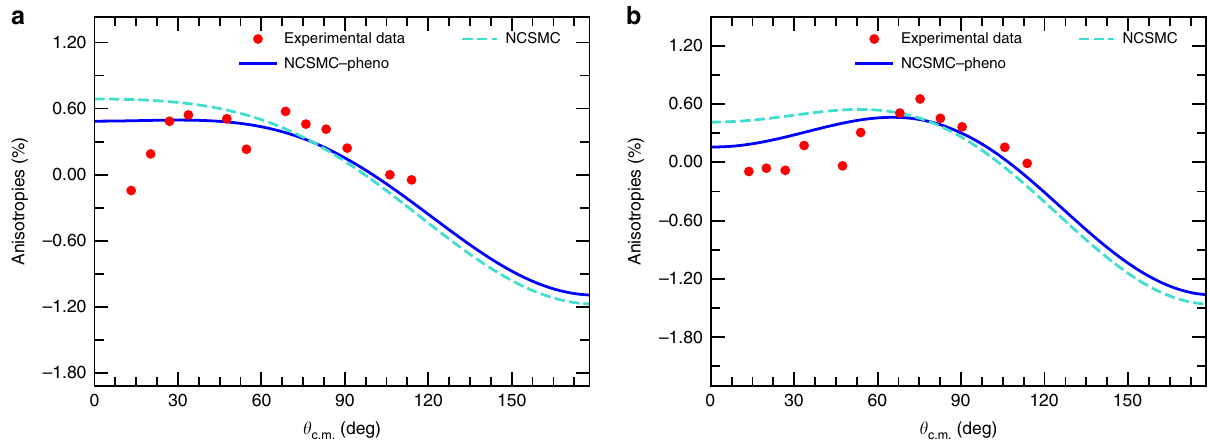
Fig. 2 Anisotropy in the unpolarized DT differential cross section. Computed and measured 30 percentage of anisotropies in the unpolarized angular distribution (obtained as percentage deviations from unity of the differential cross section divided by the total — angle integrated — cross section) as a function of the scattering angle in the center-of-mass (c.m.) frame, θ c.m. for two values of the deuteron incident energy, E D . a E D = 132.8 keV. b E D = 174.7 keV. In the fi gures “ NCSMC ” and “ NCSMC-pheno ” stand for the results of the present calculations before and after a phenomenological correction of − 5 keV to the position of the 3/2 + resonance and “ Experimental data ” are the measurements from ref.